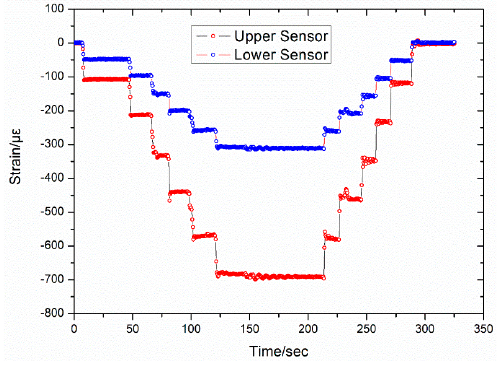
Figure 8. Comparison between the upper and lower FBG.